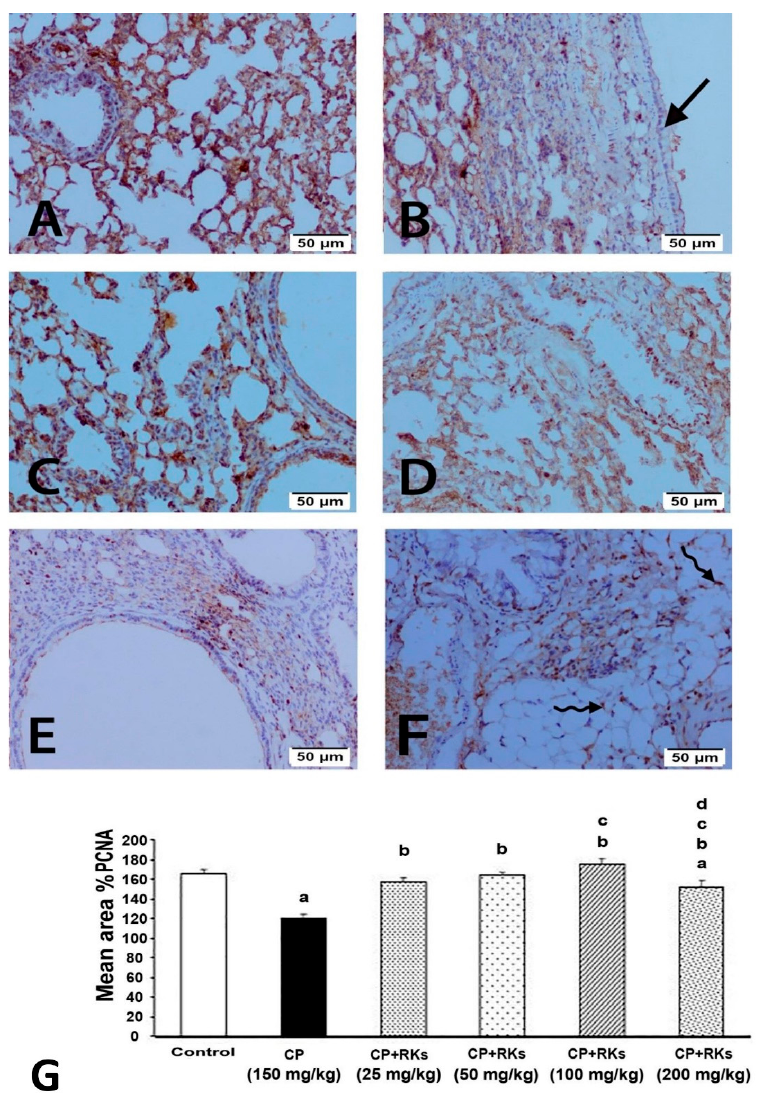
Figure 4. Photomicrographs showing PCNA immunoexpression on the lung tissue of di ff erent experimental groups. ( A ) Moderate immunoreactivity of control group. ( B ) Negative immunoreactivity of lining epithelium of bronchioles of CP group (arrow). Note that the treated groups with RKs ( C ) 25 mg / kg, ( D ) 50 mg / kg, ( E ) 100 mg / kg and ( F ) 200 mg / kg were positive; the most intense in the lining epithelium of alveoli of treated group with 200 mg / kg (curved arrow). ( G ) graph of the mean area % of immunoreaction to PCNA. Results are expressed as mean ± S.E. and analyzed using One Way ANOVA followed by Bonferroni’s post-hoc test at p ≤ 0.05 ( n = 4–6). a Indicates significant di ff erences from + control (Control) mice. b Indicates significant di ff erences from CP, c Indicates significant di ff erences from RKs (25 mg / kg / p.o), d Indicates significant di ff erent from RKs (50 mg / kg /